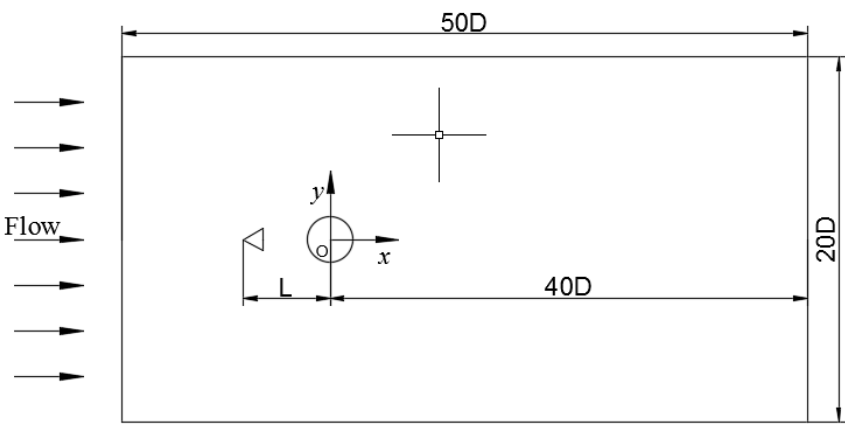
Figure 1. The computational domain and the positions of the wedge and the main cylinder. Table 1. Parameters of the flow control simulation at Re = 200. Re: Reynolds number. L /